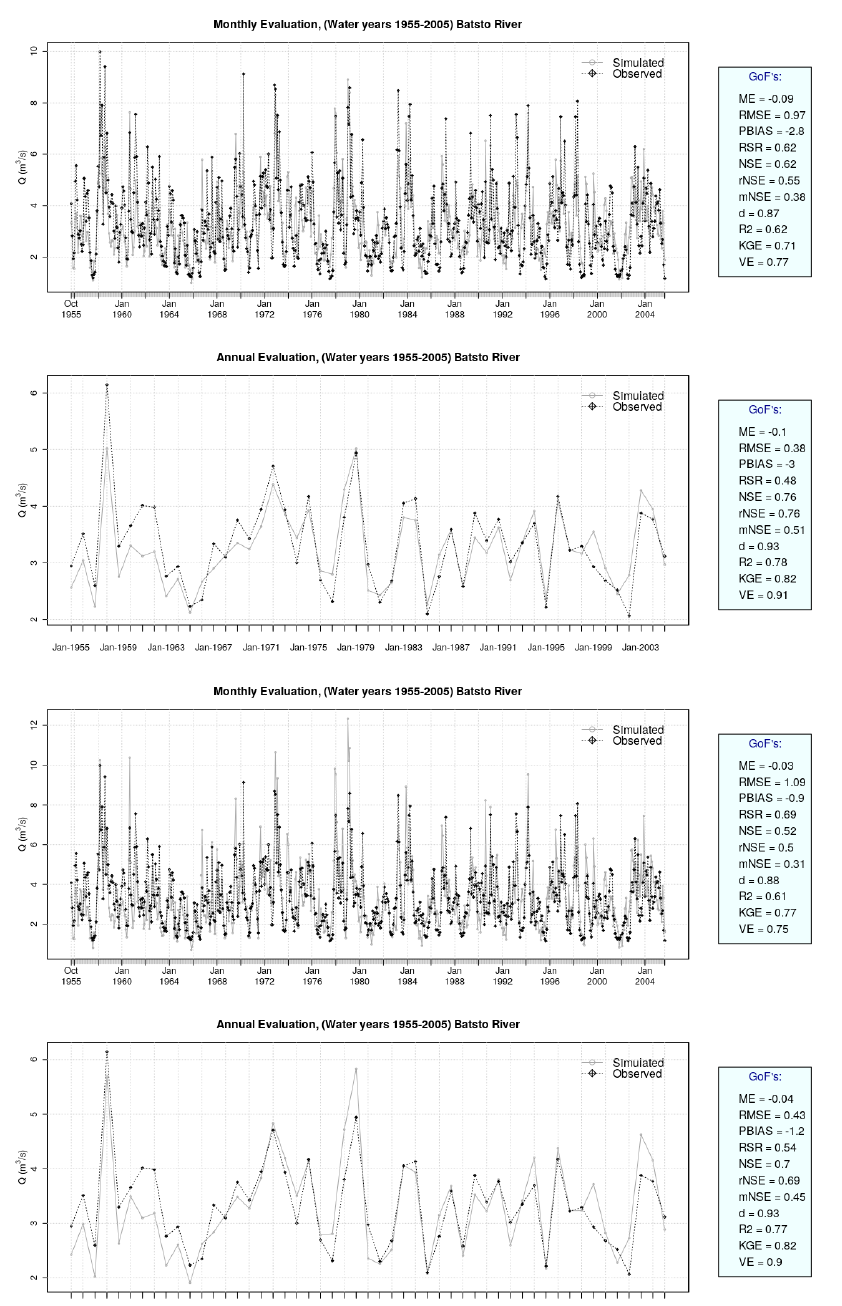
Figure 3. Goodness-of-fit for monthly mean flow (m 3 s − 1 ; top) and annual mean flow (second row) for uncorrected (UC) and monthly mean flow (third row) and annual mean flow (bottom) for bias-corrected (BC) PRMS simulations in the Batsto